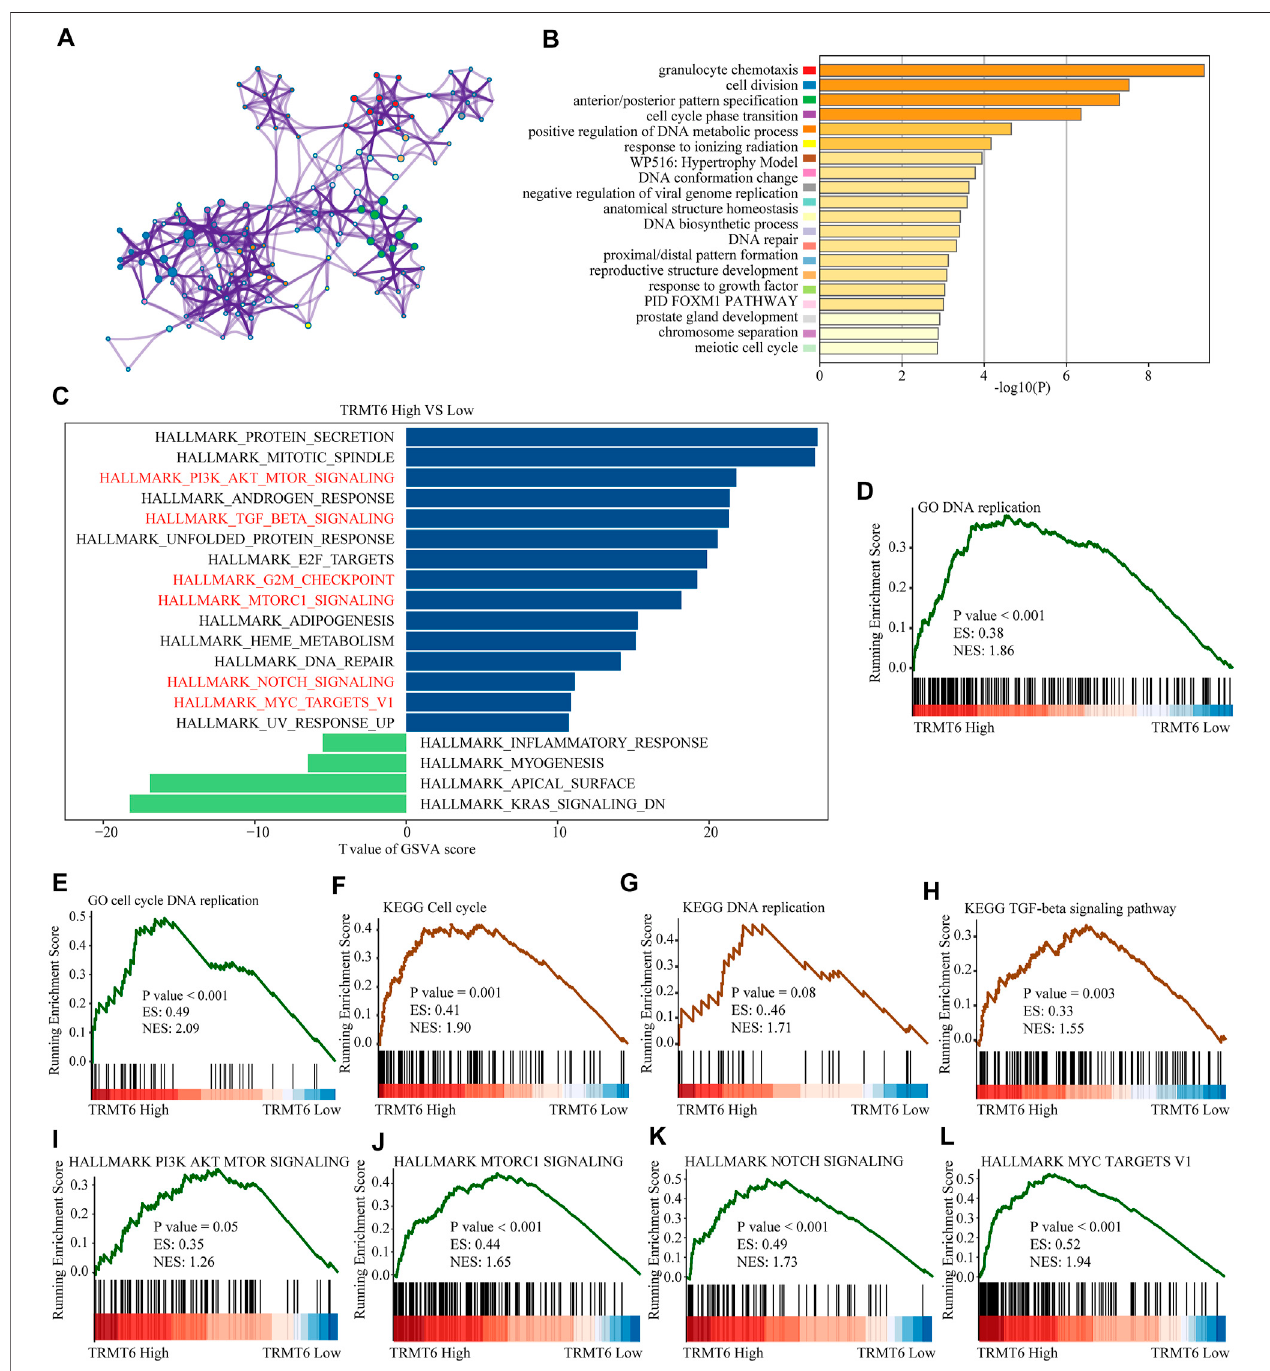
FIGURE 6 | Functional annotation of TRMT6 in glioma. (A,B) The network and bar chart of the top 20 signi fi cantly enriched biological pathways of upregulated genesinpatientswithhighTRMT6expression.Eachenrichednodeispresentedinadifferentcolor. (C) GSVAbetweenhigh – andlow – TRMT6expressionpatientsusing hallmark gene sets. (D – H) GSEA revealed that cell cycle, PI3K-AKT, TGF-beta, MTORC1, NOTCH, and MYC pathways were signi fi cantly enriched in patients with high TRMT6 expression.